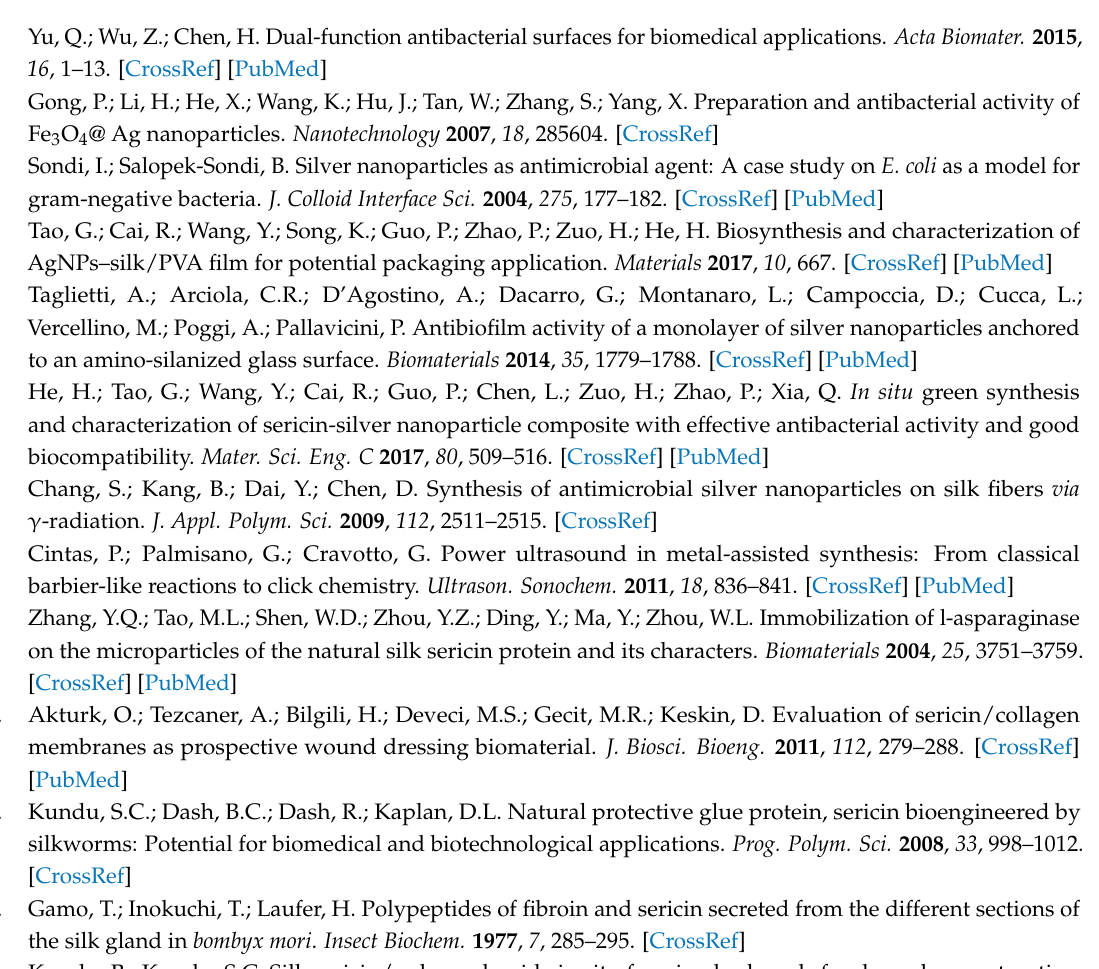
Figure S1: SEM image of AgNPs-PEM-SS/Agar film (A) and size distribution analysis of AgNPs (B), Figure S2. Swelling ratio of different films in PBS buffer (pH 7.4) at different